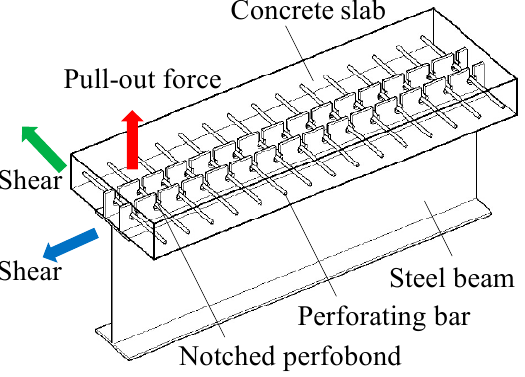
Figure 1. Application of notched perfobond shear connector.